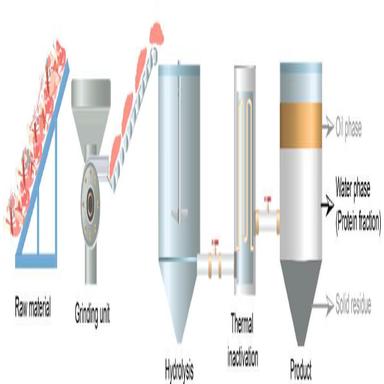
Sketch of industrial enzymatic protein hydrolysis of rest raw materials from the food industry.